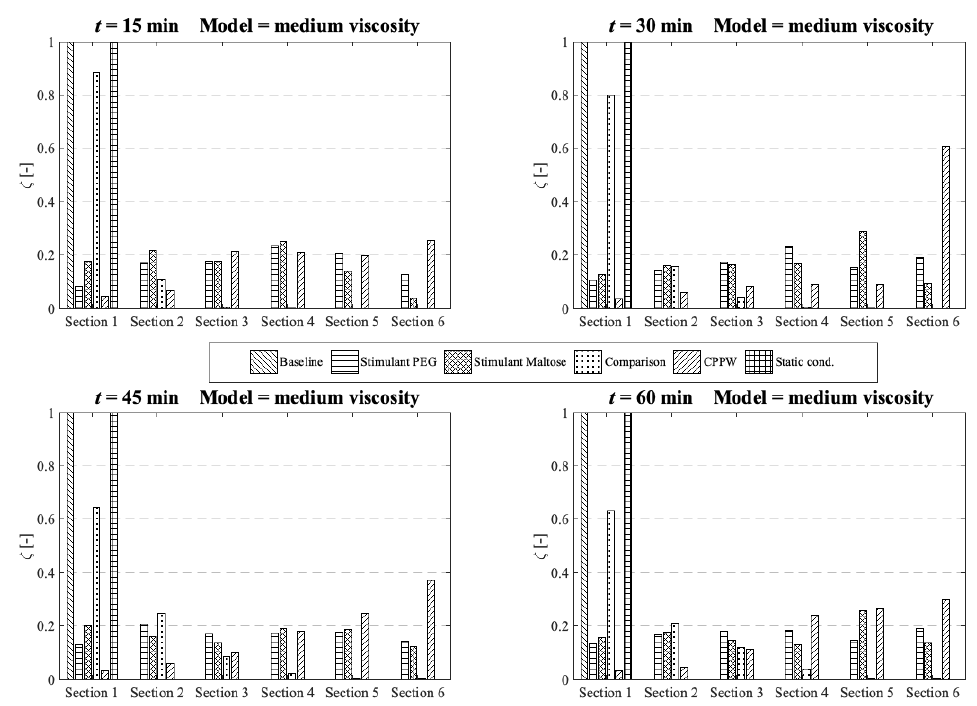
Figure 11. Comparison of the different models in respect to the distribution of the API along the colon at four different times at medium fluid viscosity conditions.